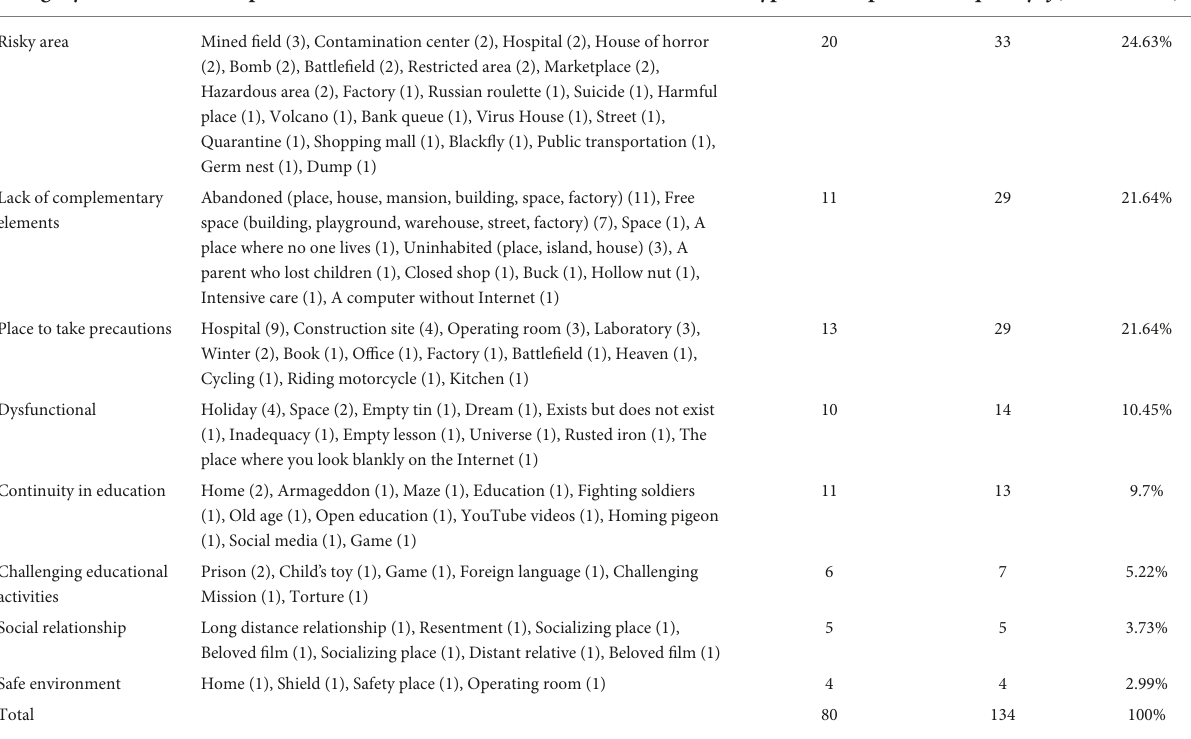
TABLE 11 Categories of metaphors created by high school students regarding the concept of “school during COVID-19.” Category